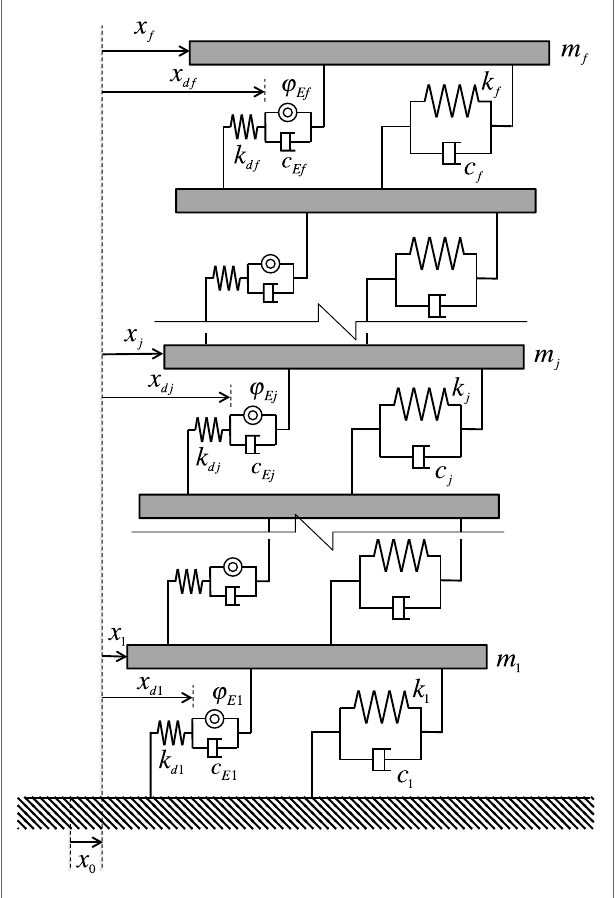
FIGURE 5 | A multistory shear building with tuned electromagnetic inertial mass dampers